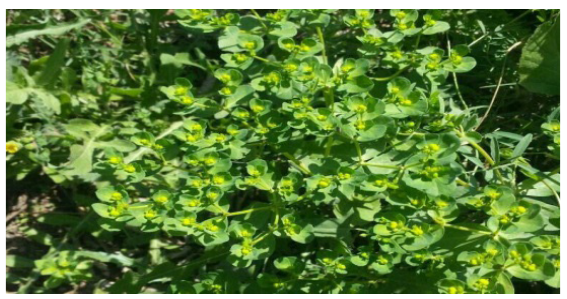
Figure 1: a, b and c shows selected medicinal plants for antiprotoscolices potential against E.